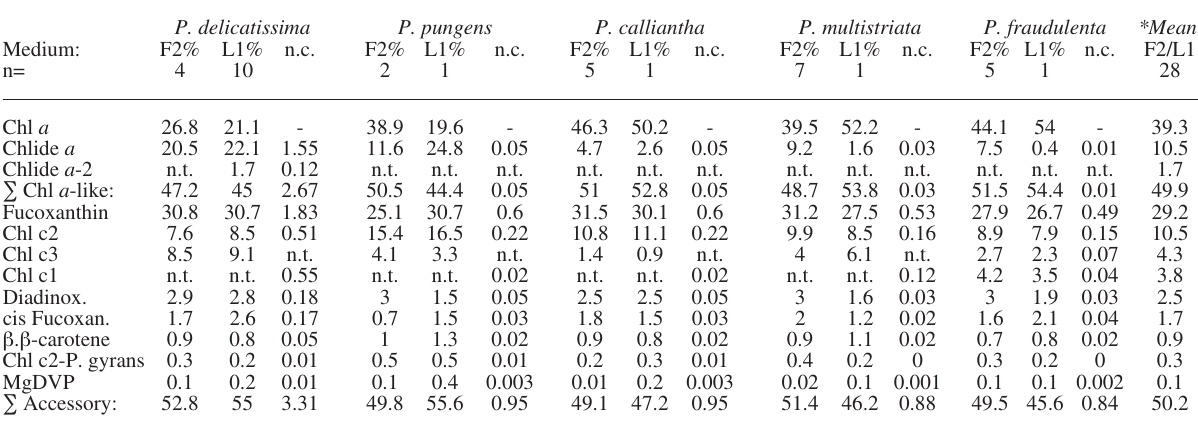
Table 2. – mean relative contributions of chl a (n.c.). degradation products and accessory pigments to the total pigment load (%) determined for a culture collection of five different Pseudo-nitzschia species grown in F2 and L1 culture media. vertical arrangement of accessory pig- ment is based on descending mean relative